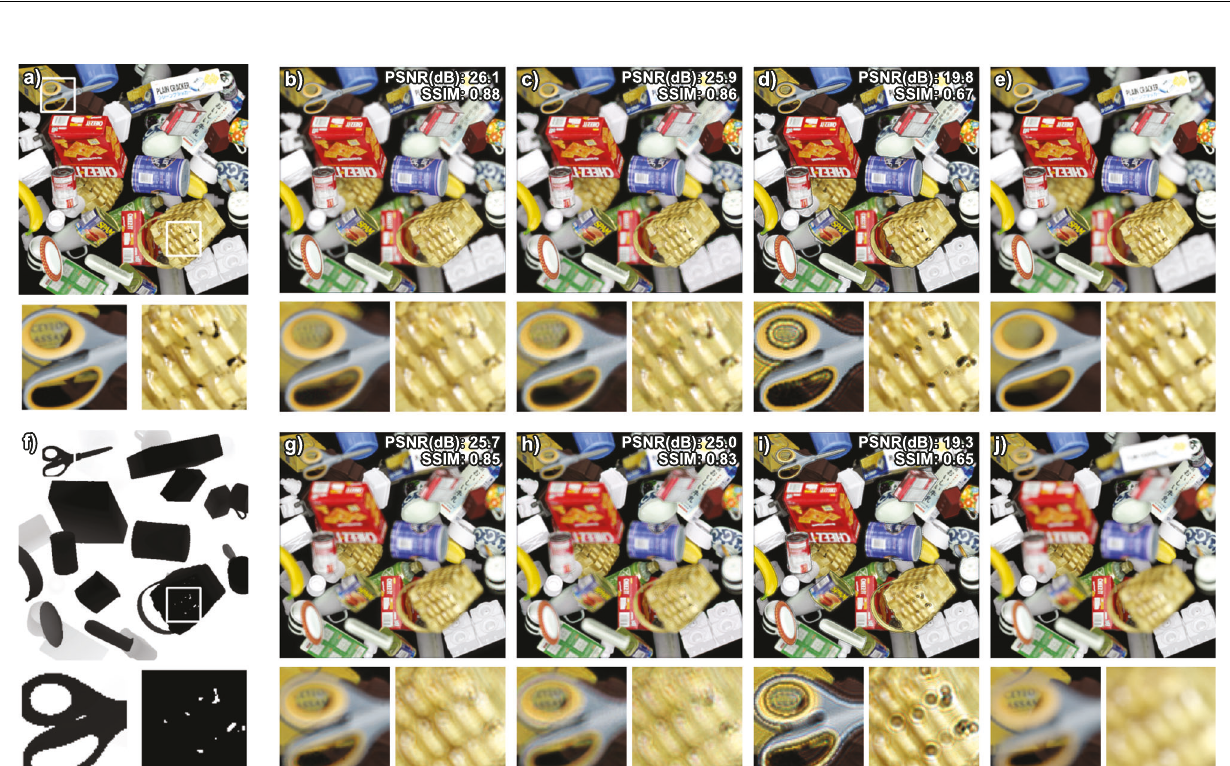
Fig. 2 | Reconstructed intensities of different algorithms and schematics of DEHNet.a In-focusandout-of-focusintensitiesoftherenderedcase,thedCGH,the nCGH, and the DEH are simulated (from top to bottom). The side lengths of the